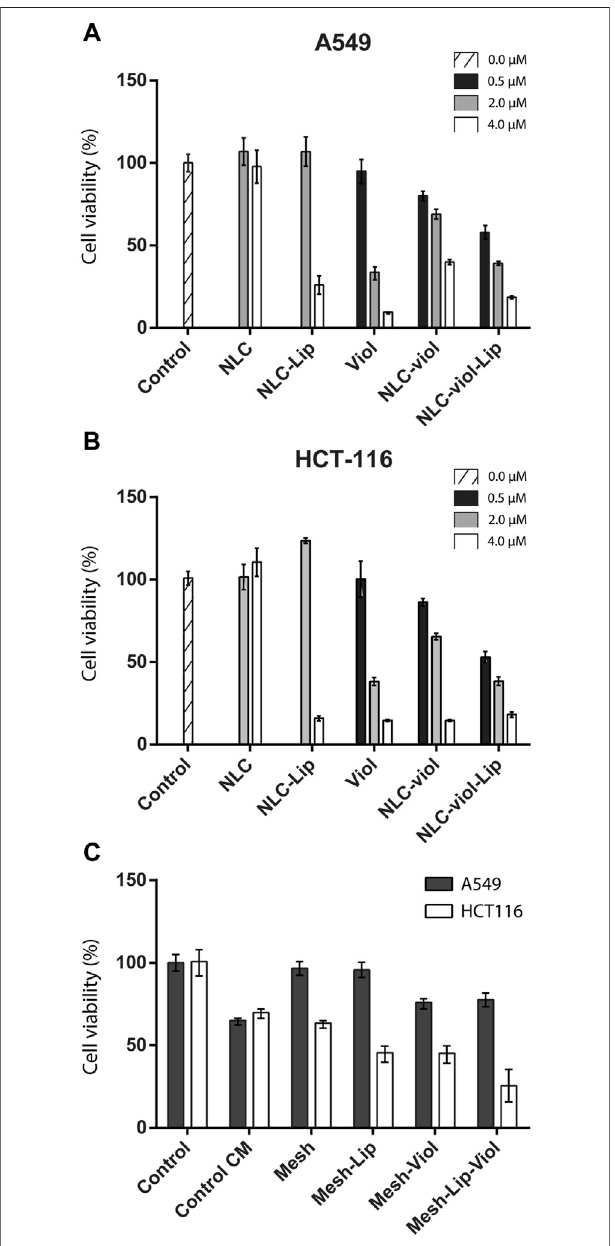
FIGURE 10 | Cell viability For NLC formulations and free Viol in A549 (A) and HCT-116 (B) cell lines, respectively. Cell viability on conditioned medium (C)